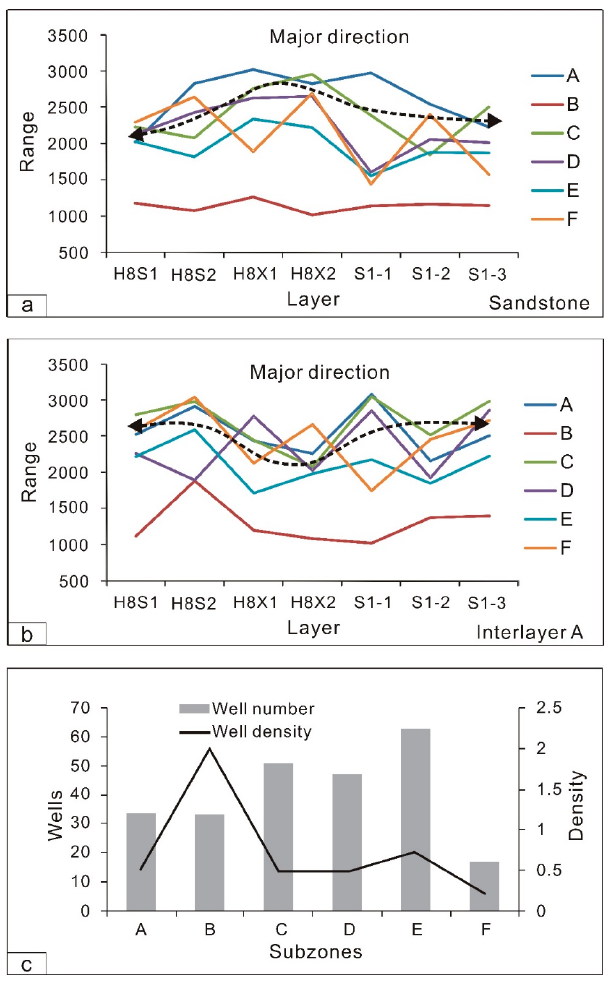
Figure 9. Relationships between layers and major direction ranges of different subzones. As shown in the figure, both the major direction ranges of sandstone and interlayer A for the six subzones are characterized by obvious horizontal and vertical fluctuations. ( a ) The ranges of sandstone for the braided intervals H8X1 and H8X2 are relatively larger than those for the meandering intervals (H8S1, H8S2, S1-1, S1-2 and S1-3); ( b ) The ranges of interlayer A for the braided intervals are relatively smaller than those for the meandering intervals; ( c ) Statistics of well numbers and well densities for the six subzones.